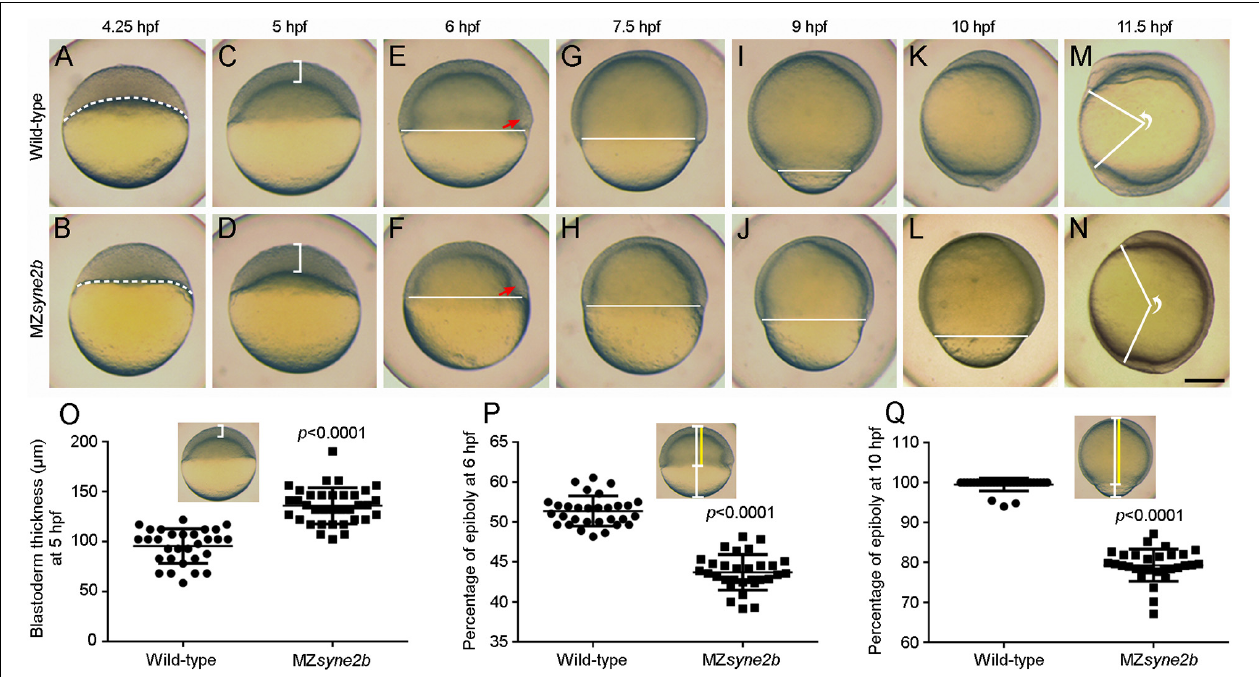
FIGURE 3 | Disruption of Syne2b function impairs epiboly movement and anteroposterior axis elongation. Live images show epiboly initiation and progression in time-matched embryos. Lateral views with animal pole or anterior region on the top. (A,B) At 4.25 hpf, yolk cell domes into the blastoderm in wild-type embryos, while the border between the blastoderm and the yolk cell (broken lines) remains flat in MZ syne2b embryos. (C,D) At 5 hpf, the blastoderm in MZ syne2b embryos is thicker compared with wild-type embryos (brackets). (E,F) At 6 hpf, MZ syne2b embryos show delayed epiboly compared with wild-type embryos (horizontal lines). Red arrows indicate the embryonic shield. (G–J) At 7.5 and 9 hpf, delayed epiboly progression is evident in MZ syne2b embryos. (K,L) At 10 hpf, wild-type embryos complete gastrulation, whereas MZ syne2b embryos only reach about 80% epiboly. (M,N) At 11.5 hpf, wild-type embryos develop a long anteroposterior axis, while MZ syne2b embryos only complete gastrulation. The angle formed between the most anterior end and the most posterior end of the anteroposterior axis, with vertex at the geometric center of the embryo, reflects the extent of axis elongation. (O) Scatter plot compares blastoderm thickness between wild-type and MZ syne2b embryos. (P,Q) Scatter plots compare epiboly progression between wild-type and MZ syne2b embryos. Scale bars: (A–N) 200 µ